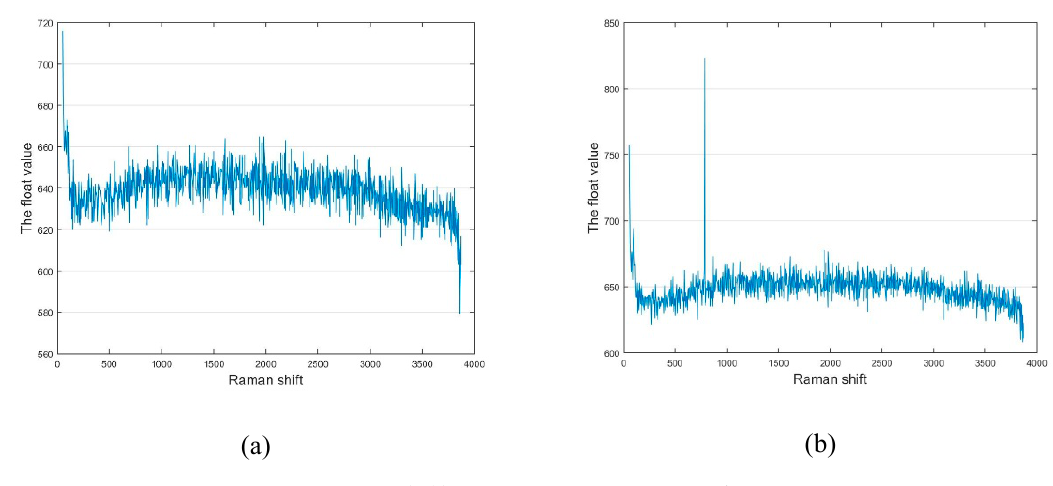
Figure 11. ( a , b ) Raman raw measurement data. Figure 11. ( a,b ) Raman raw measurement data.